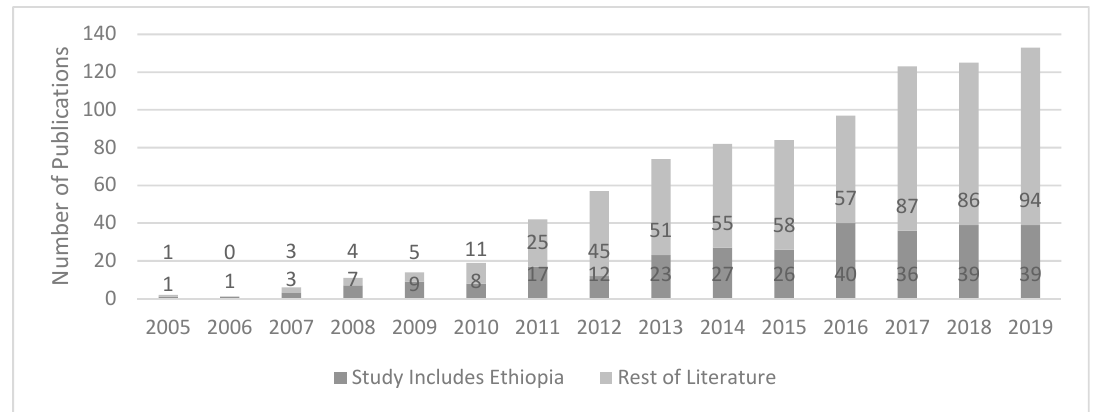
Figure 1. Web of Science-indexed publications—combined results of “land grabbing”, “large-scale land acquisition”, “agricultural investment” (2005–2019).